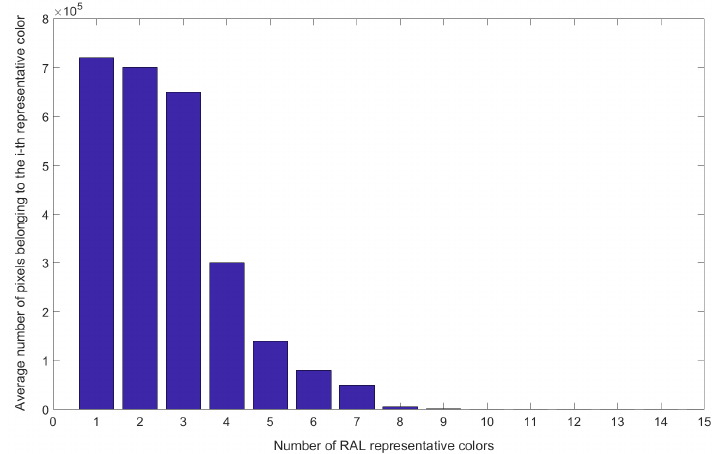
Figure 4. Average number of pixels belonging to a given RAL class for the whole set of images processed for the training set.